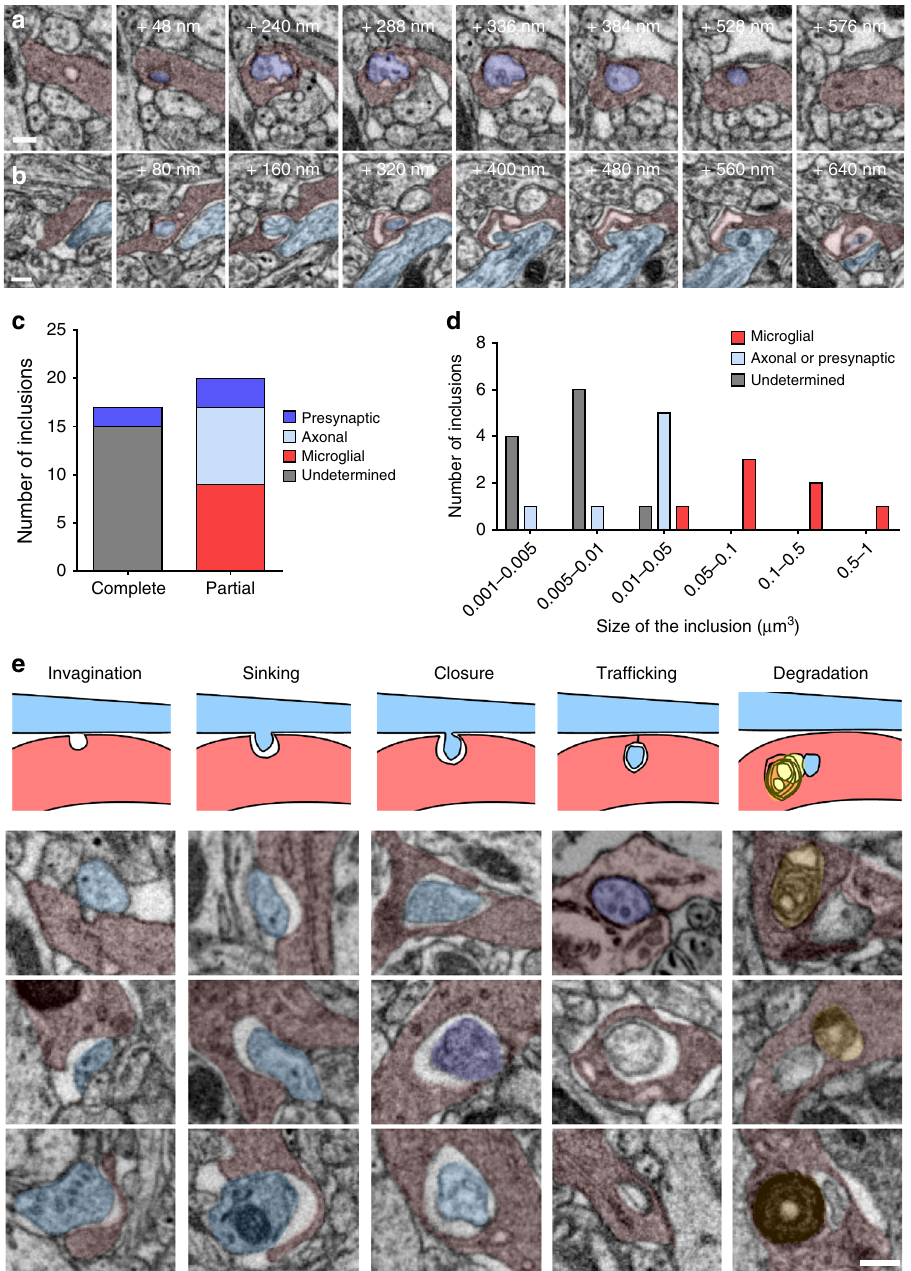
Fig. 3 Microglia trogocytosis of presynaptic boutons and axons. Representative FIB-SEM image sequences of a complete presynaptic bouton inclusion (dark purple), as identi fi ed by its 40 nm vesicles content, inside microglia (red), b partial inclusion containing axonal material (clear blue) inside a microglia. c Quanti fi cation of microglial partial and complete inclusions (n = 37 inclusions from 8 cells, 4 animals). d Distribution of the volume of microglial inclusions. e Putative sequence of events leading to presynaptic bouton or axon material digestion by microglia, represented by a schematic and a collection of three examples for each step (gray: undetermined origin, yellow: lysosomes). Scale bars: 200